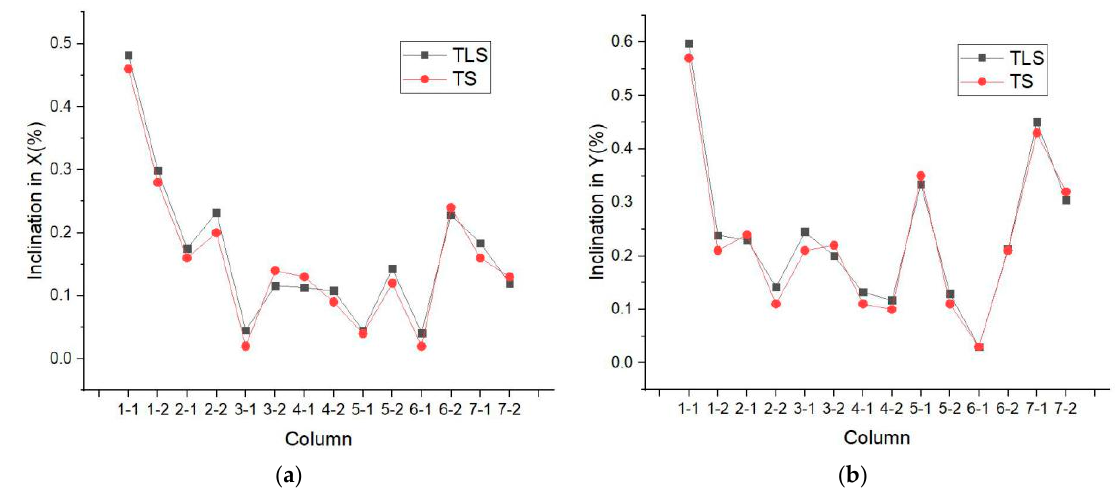
Figure 11. Comparison of two methods: ( a ) inclination in X; ( b ) inclination in Y